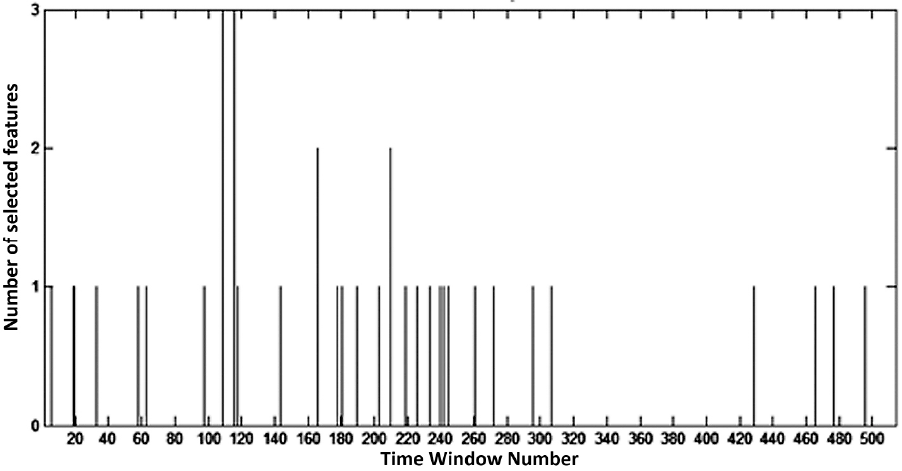
Figure 11. Number of selected features per time window.